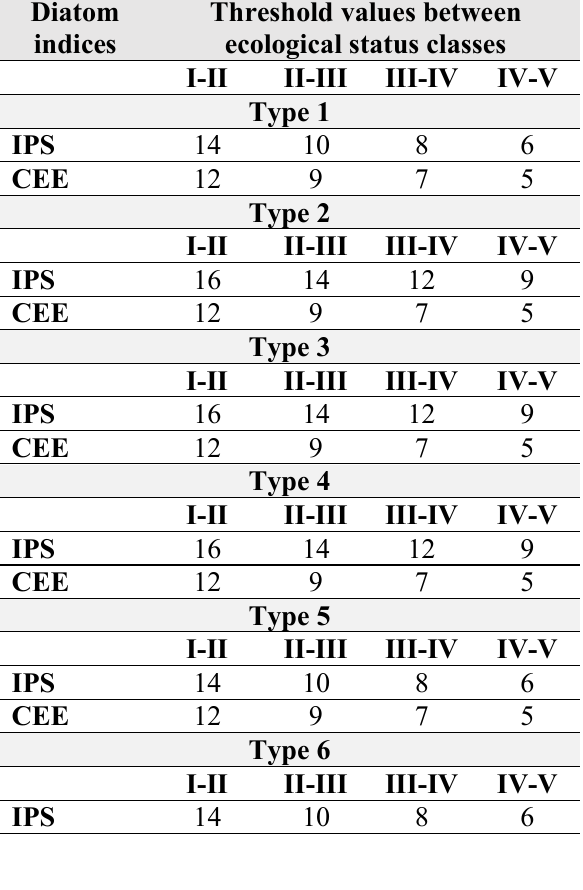
Table 1. Threshold values of IPS and CEE diatom indices for six types, according to the National Regulation (Anonymous,